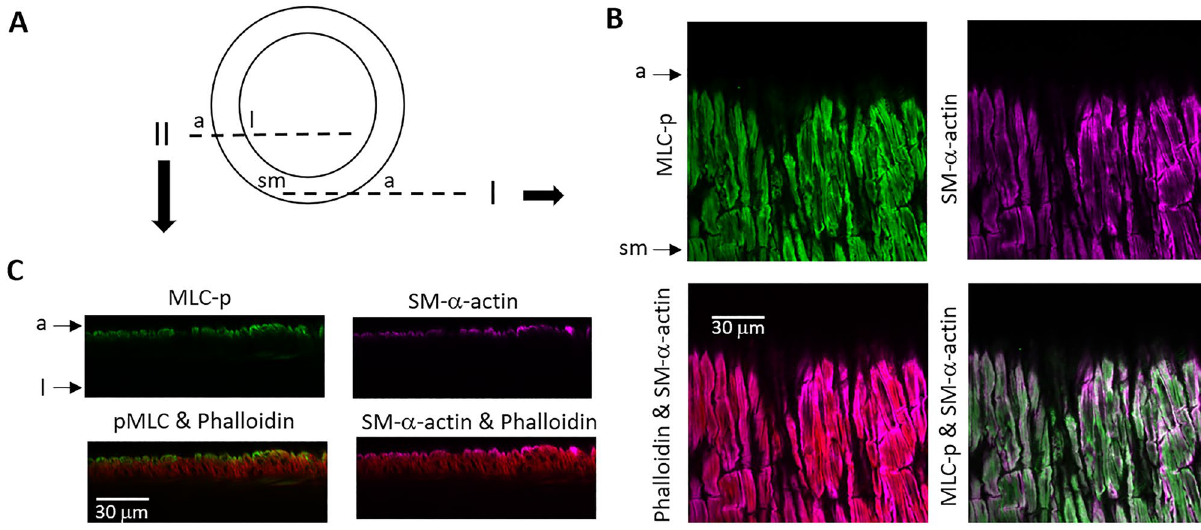
Figure 1. Gradient distribution of MLC-p and SM-α-actin in the vessel wall of SCA. ( A ) Illustration of the longitudinal circumferential view (I) and the longitudinal sectional view (II) of the vessel wall. ( B )